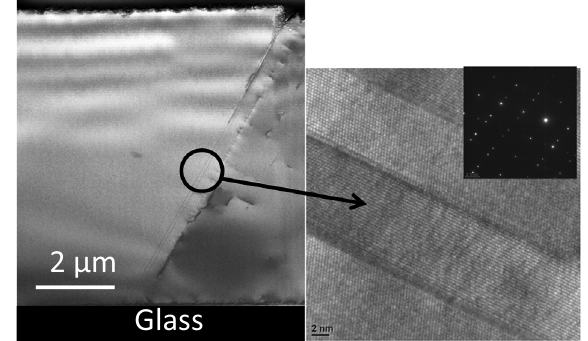
Fig. 3. (Left) TEM image of diode laser crystallised Si grains with twin boundary (circle) and dislocations; (right) high res- olution TEM image of defect-free twin boundary.